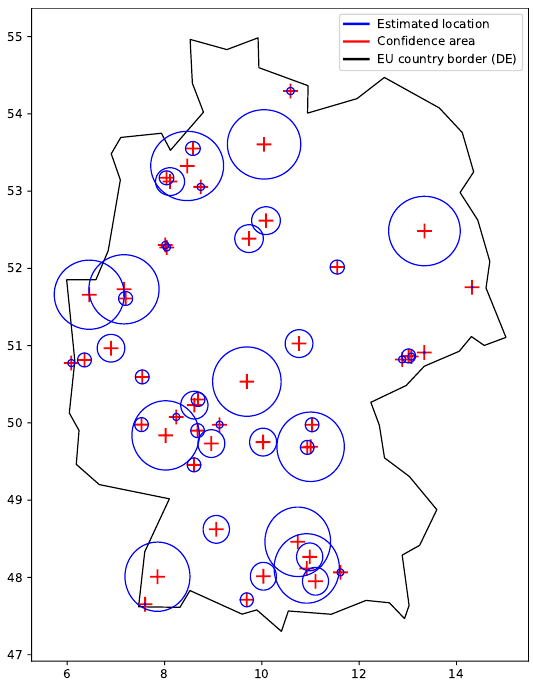
Figure 6. Confidence area and locations derived for sample IP addresses. Large areas are excluded and relatively small area boundaries are used within a country.